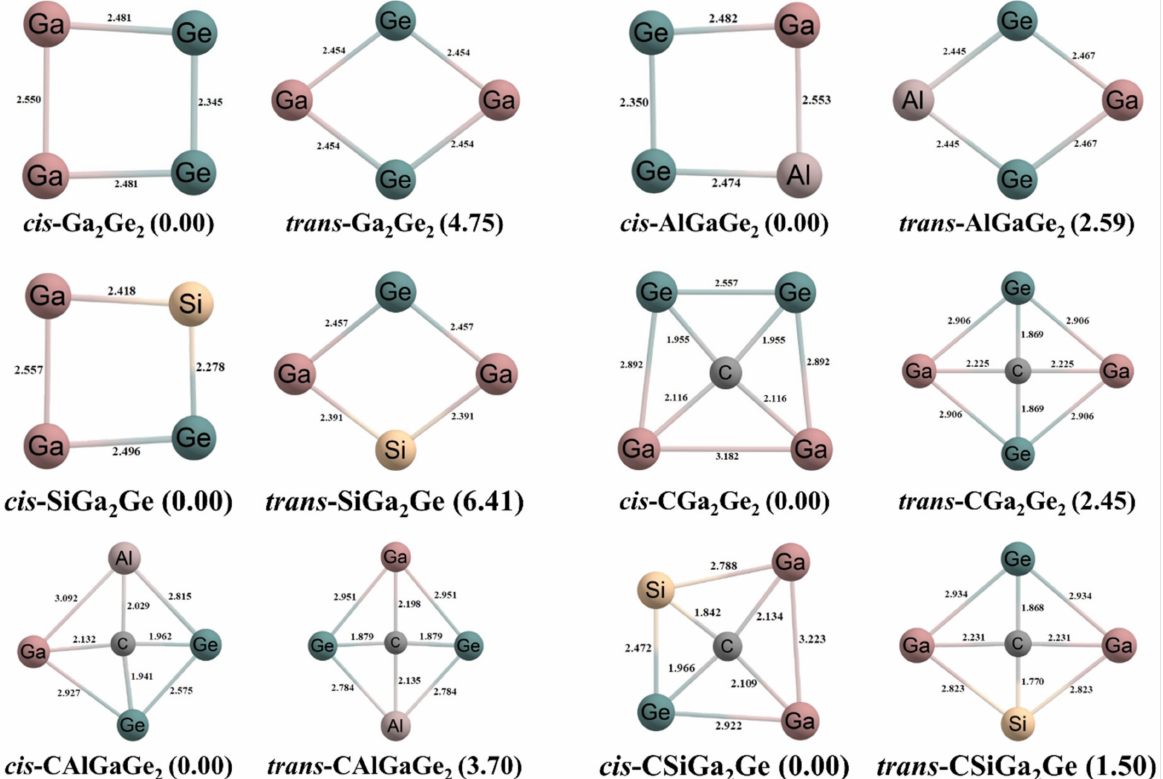
Figure 1. The optimized geometries of the cyclic rings and the ptC systems. Bond lengths are given in Å unit. The values in the parentheses are the relative energies in kcal/mol. The energies of cis isomers are considered to be